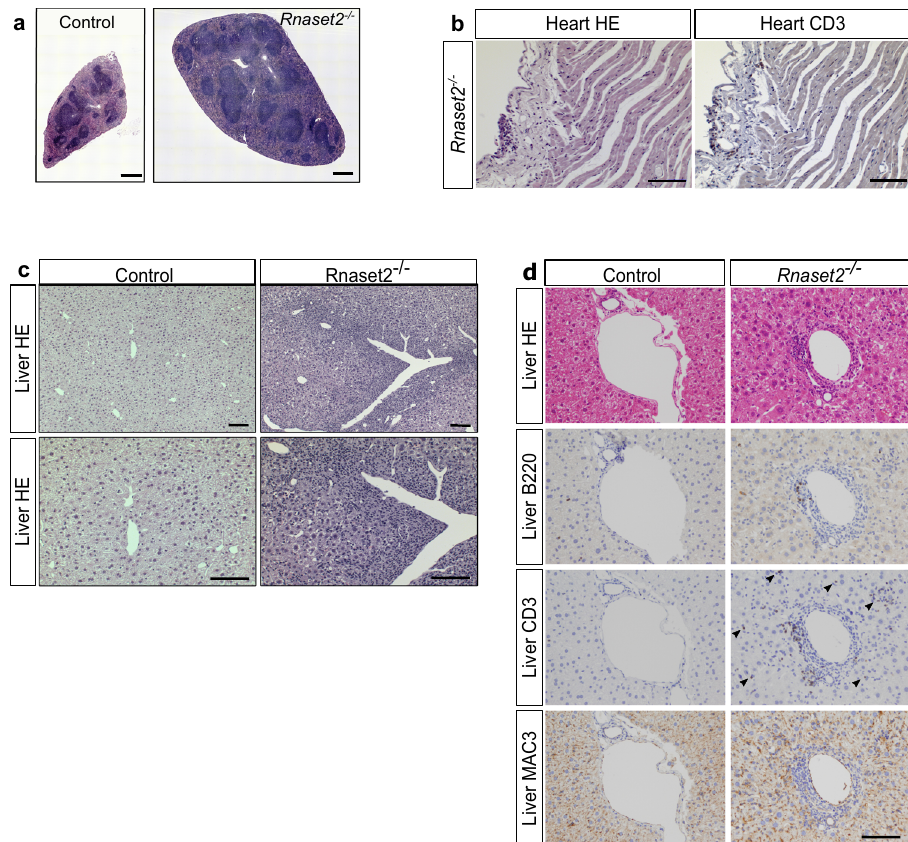
Fig. 2 In fl ammatory organ disease. a Stitching of haematoxylin-eosin (HE) stained whole spleen cross section illustrates the enlargement and disorganisation of white splenic pulp in a 5-month-old mouse. ×20 magni fi cation. Scale bar, 500 µ m. b HE staining of the heart showed lymphocytic in fi ltrates in the pericardium. Immunohistochemical staining revealed most of them as CD3 + T cells. Scale bar, 100 µ m. c Histological HE staining of slides from PFA- fi xed and paraf fi n-embedded liver. In fl ammatory lymphocytes in fi ltrate around the periportal fi elds pointing to a hepatitis. ×10 and ×20 magni fi cation. Scale bar, 100 µ m. d Immunohistochemical staining of periportal in fi ltrating cells revealed presence of B220 + B cells, CD3 + T cells and activated macrophages (MAC3 staining). Notice, T cells were spread over the whole liver parenchyma (arrowheads). ×20 magni fi cation. Scale bar, 100 µ m. Images are representative of seven independent